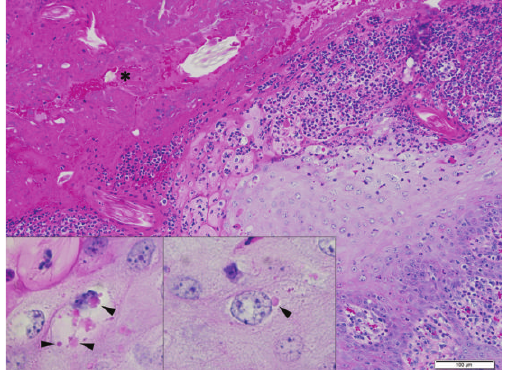
Figure 6: Haired skin, lip commissure. Epithelial hyperplasia, necrosis, and loss with overlying serocellular crust ( ∗ ) composed of keratin, proteinaceous fluid, degenerate neutrophils, and numerous mixed bacteria. Insets: rarely keratinocytes demonstrate large clear cytoplasmic vacuoles (ballooning degeneration) (left) and contain one or more 2–10 𝜇 m round, brightly eosinophilic intracytoplasmic inclusion bodies (left and right, arrowheads). Hematoxylin and eosin stain, 20x objective.